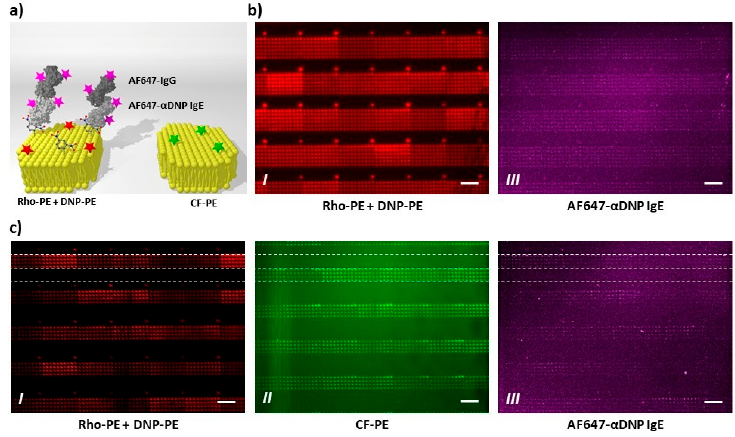
Figure 7. Specific antibody binding on antigen-containing lipid arrays. ( a ) Schematic outline of the performed experiments. The presented antigens were specifically stained by Alexa Fluor ® 647 (AF647)-labeled anti-dinitrophenol (DNP) IgE antibodies, followed by incubation with an AF647-labeled secondary antibody. AF647 signal from the labeled antibodies is expected in co-localization with spots containing DNP-conjugated lipids (DNP-PE, left part of scheme), while no signal should be present in absence of DNP-PE (right); ( b ) One-color experiments: 6 × 10 spot arrays containing DOPC (as carrier lipid), dotted with 1% Rho-PE and with 10% DNP-conjugated lipid (DNP-PE), were printed; ( c ) Two-color experiments: Two adjacent 4 × 10 spot arrays were printed with two di ff erent inks. The first contains DOPC (as carrier lipid), 1% Rho-PE, and with 10% DNP-conjugated lipid (DNP-PE), while the second contains DOPC and 2% Carboxyfluorescein-conjugated lipids (CF-PE). The results confirm accessibility and specific recognition of the presented antigens, since AF647 signal (panel III) is detected in co-localization with DNP-containing arrays (panel I) and absent on negative control arrays (panel II). Note that the number of columns and rows in the arrays appear inverted, since the images were clockwise rotated for a clearer results interpretation of two-color experiments. In addition, the images in Figure S9 ensure no crosstalk between the fluorescence channels, confirming that the detected AF647 signal uniquely rises from bound antibodies. All scale bars equal 50 µ